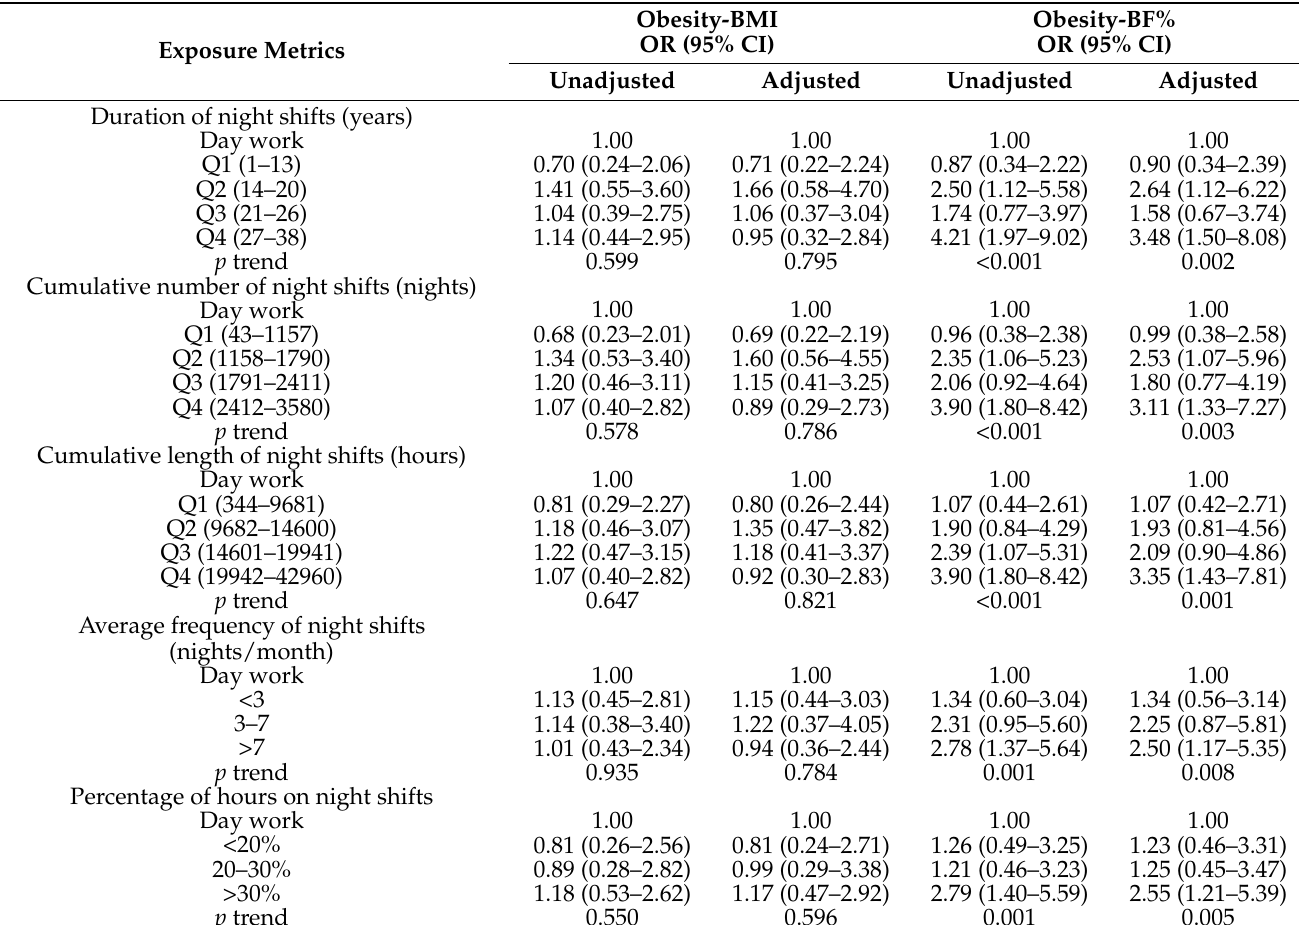
Table 3. Associations of different exposure metrics of night shift work with obesity